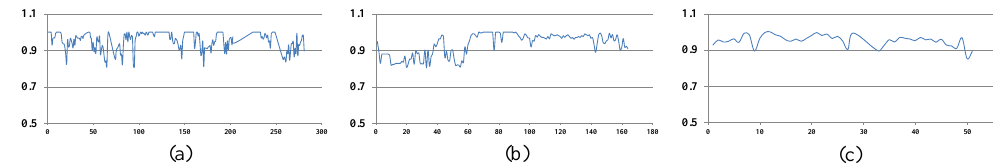
Figure 19. ACC plot of our estimation on ( a ) bear_front, ( b ) child_no1, and ( c ) new_ex_occ4 video sequences of PTB data set [1]. Error value one represents the best estimation.